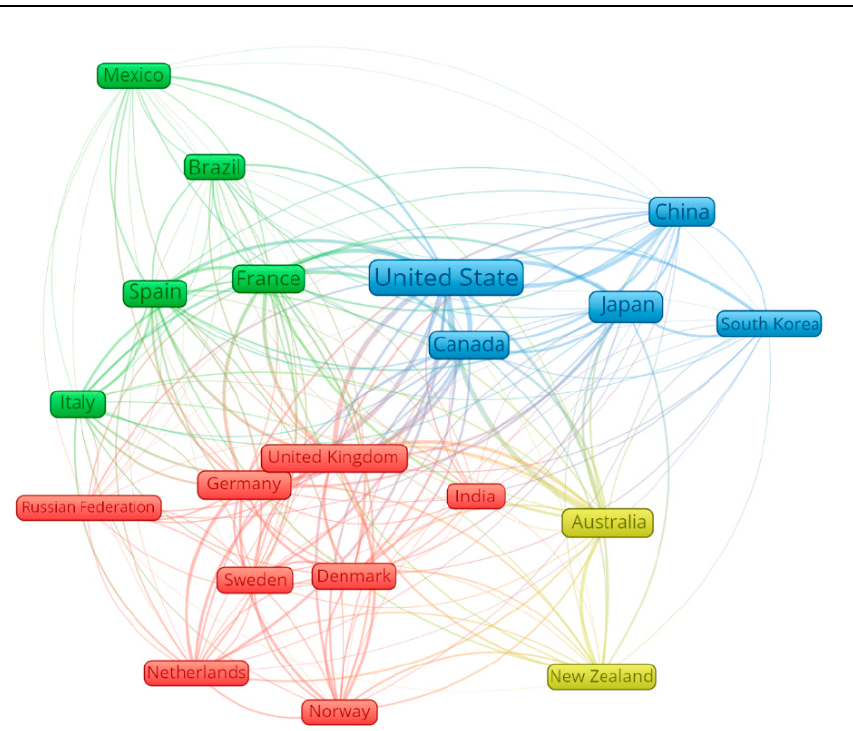
Figure 3. Visualization map of countries communities regarding dinoflagellate research.